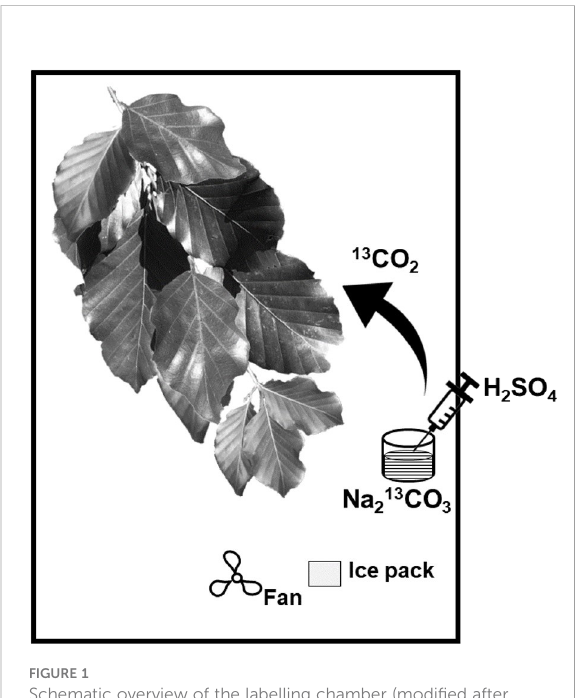
FIGURE 1 Schematic overview of the labelling chamber (modi fi ed after Kagawa et al.,